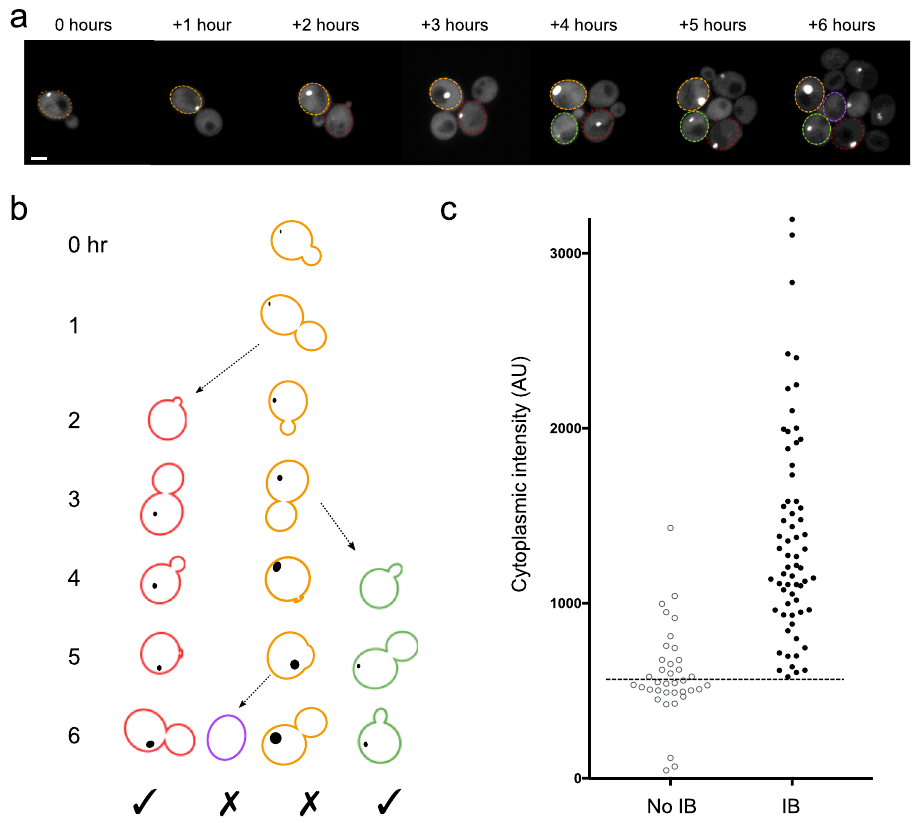
Fig. 3 A threshold cytoplasmic concentration is required for inclusion body formation. a The timecourse is shown in Fig. 2, but here the outlined cells indicate the four cells shown in b . b In this analysis, we considered only cells that acquired an inclusion body (IB) during the experiment and cells that did not acquire an IB but were born at least 3 h before the end of the experiment. c Each data point reports the average cytoplasmic intensity of a cell that formed an IB (IB, n = 65) or did not form an IB (no IB, n = 37) during the course of the experiment. The intensities of the two groups are signi fi cantly different ( p < 0.0001, unpaired t -test, two- t ailed distribution assuming unequal